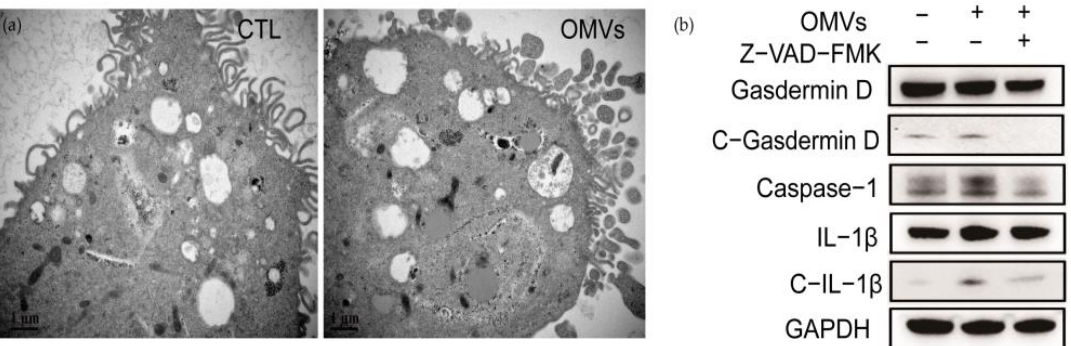
Figure 6. OMVs secreted by D. fairfieldensis caused THP-1- Mφ cell morphological changes and pyroptosis. ( a ) OMVs from D. fairfieldensis (1 μg /mL) stimulate pyroptosis of THP-1- Mφ cells. Scale bar: 1 μm. ( b ) Expression of inflammasome components by THP-1- Mφ cells induced by OMVs from D. fairfieldensis (1 μg /mL).